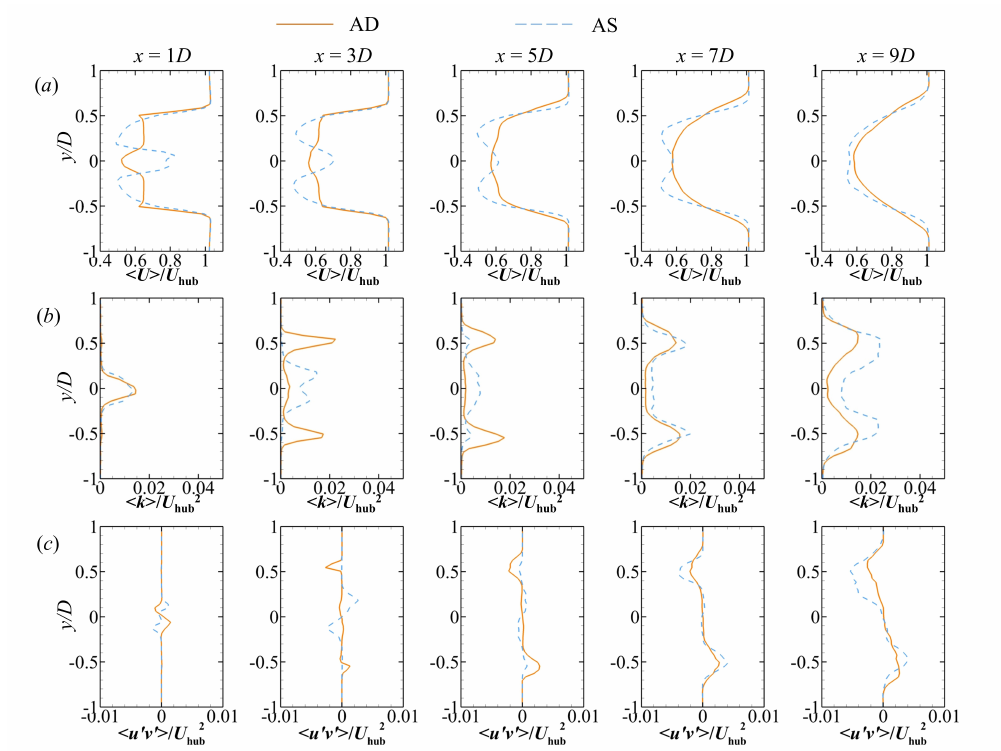
Figure 3. Uniform inflow: horizontal profiles at hub height ( z = z hub ) of the time-averaged ( a ) streamwise velocity, ( b ) turbulence kinetic energy, and ( c ) the primary Reynolds stress < u (cid:48) v (cid:48) > at different downstream